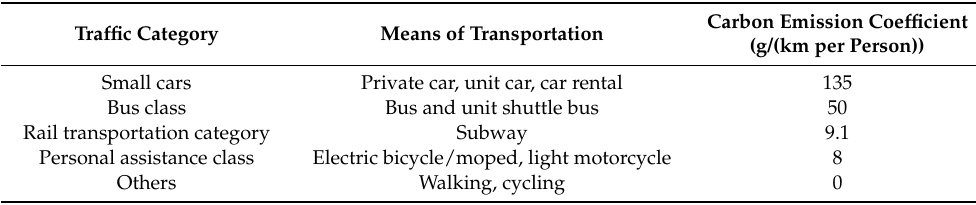
Table 2. Carbon emission coefficient of different commuting